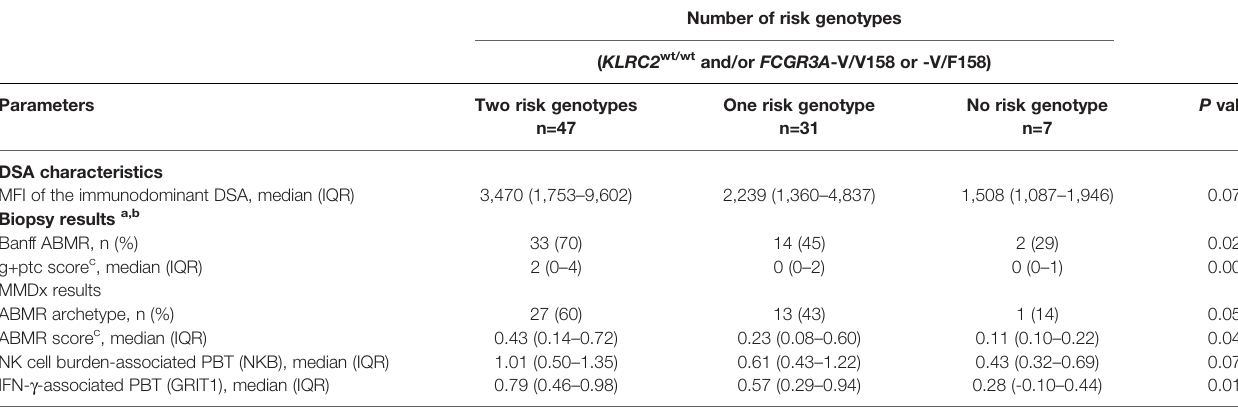
TABLE 4 | Combined analysis of NKG2C ( KLRC2) and Fc g RIIIA ( FCGR3A ) genotypes – cohort 1